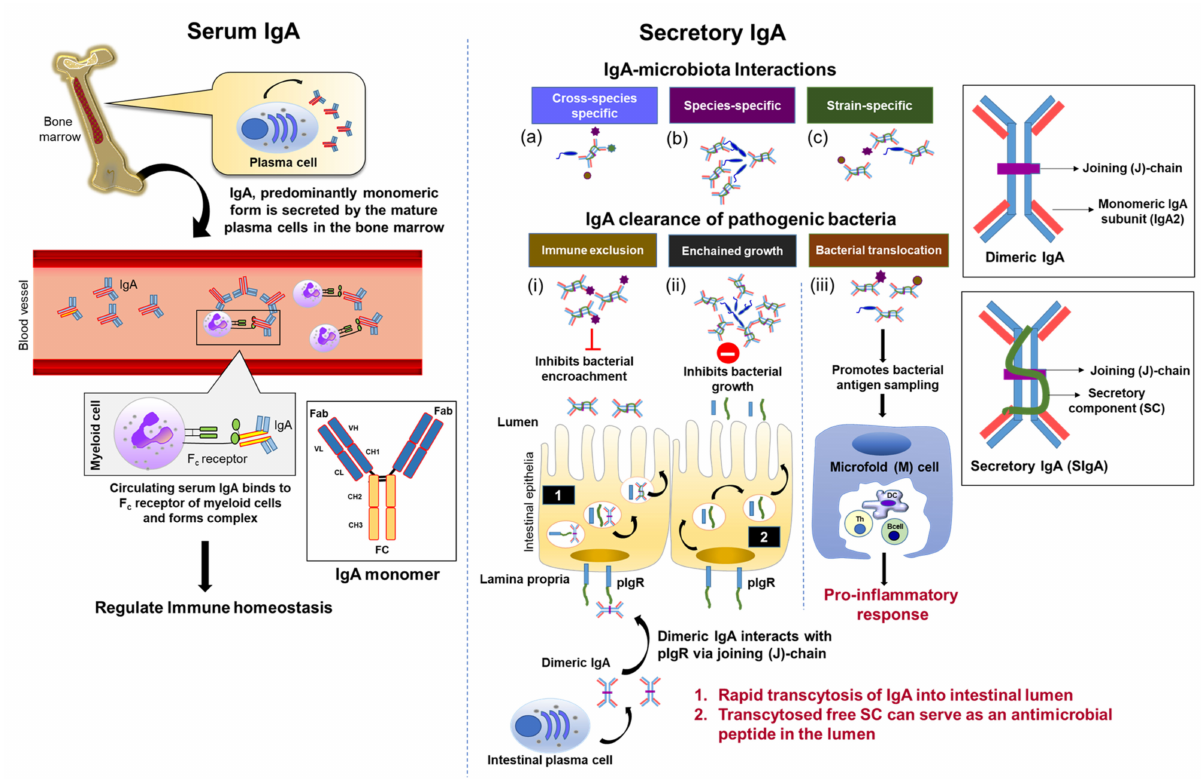
Figure 1. Structure and functions of serum and secretory IgA. In the left column, IgA, primarily monomeric IgA, is secreted by mature plasma cells in the bone marrow and enters systemic circulation. Circulating serum IgA forms immune complexes with transmembrane Fc receptors located on myeloid cells to induce downstream effector signaling necessary in maintaining immune homeostasis. In the right column, intestinal plasma cells produce dimeric IgA through divalent linkage of two IgA monomers to a joining (J)-chain. The J-chain binds to the secretory component (SC) of polymeric IgA receptors (pIgR) located on the basolateral surface of intestinal epithelial. IgA is rapidly transcytosed into the intestinal lumen as secretory IgA (SIgA). Free SC is also transcytosed into the lumen and serves as an antimicrobial peptide. Interacting with the gut microbiota, SIgA selectivity and reactivity can be categorized into either ( a ) cross-species (polyreactive) reactive against various bacterial species, ( b ) species-specific reactivity or ( c ) strain-specific reactivity. For pathogen removal, SIgA may ( i ) bind to and agglutinate bacteria, thus hindering microbial attachment and invasion of host intestinal epithelia, a process known as immune exclusion, ( ii ) prevent bacterial conjugation via enchained growth to limit bacterial proliferation, and ( iii ) expedite bacterial translocation through microfold (M) cells into Peyer’s patches for antigen sampling by resident dendritic cells